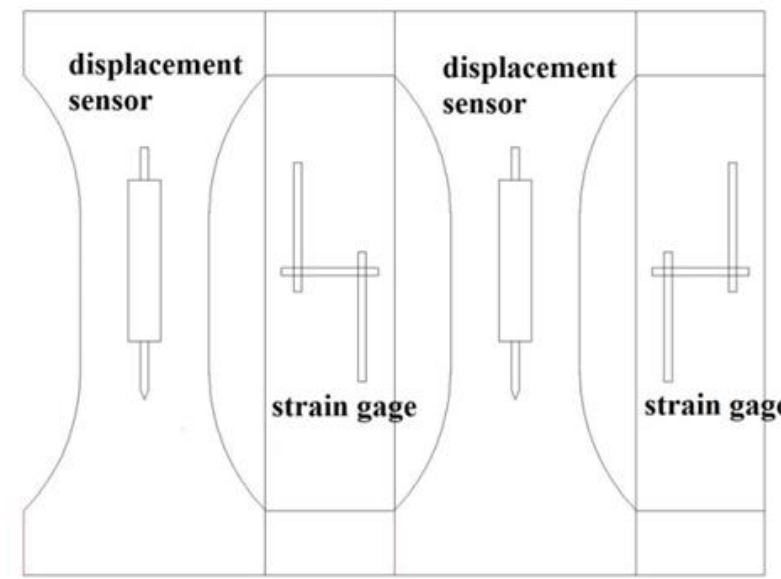
Figure 3. The location of the strain gauges attached on a sample.